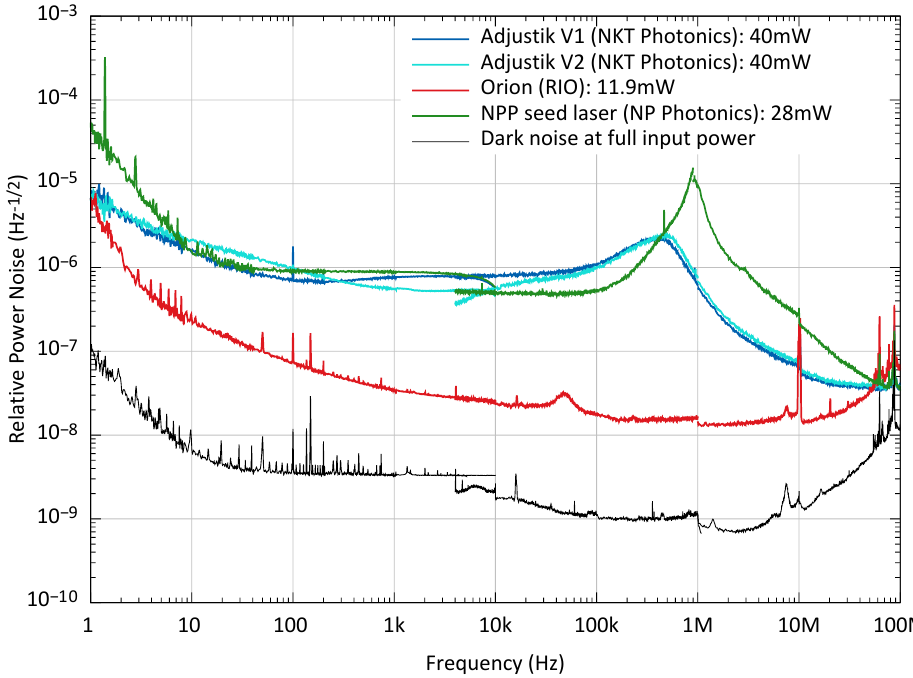
Figure 3. The free-running RPN of the seed lasers, plotted as amplitude spectral density, follow two characteristic shapes. The Orion laser has a very low free-running noise. The fiber lasers have a higher noise floor and a characteristic relaxation oscillation